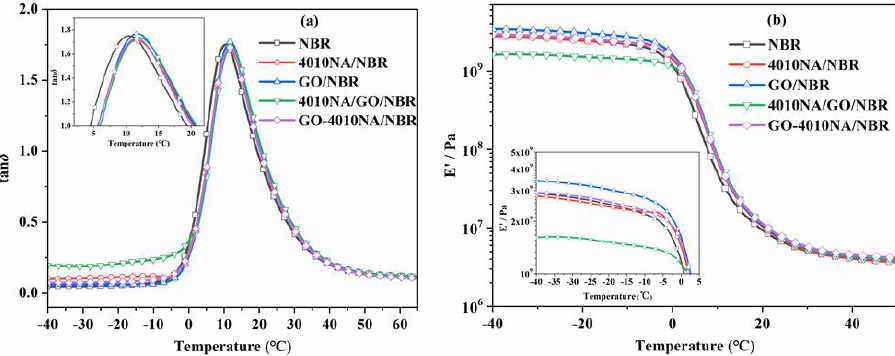
9 of 17 Figure 7. DSC curves of different NBR composites. 4.4. Dynamic Mechanical Properties of NBR Composites Figure 8 shows the temperature dependence of the loss factor (tan δ ) value and storage modulus ( E’ ) of NBR composites. Table 2 shows the damping parameters of NBR composites. When the small molecule 4010NA is added to the NBR matrix, the tan δ peak value (denote as tan δ max ) is 1.71 and the loss peak area TA is 29.58. When GO-4010NA was added, the tan δ max increased to 1.73 and TA increased to 30.05. The re-